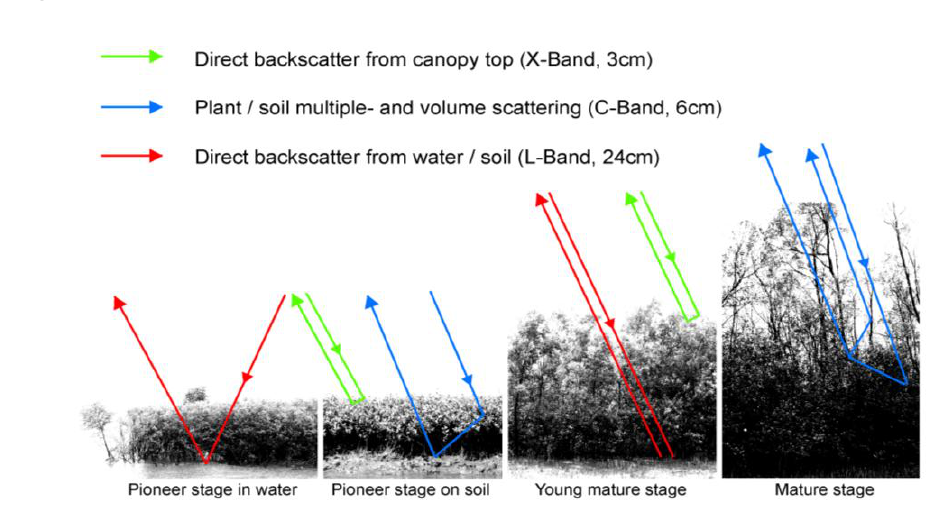
Figure 4. Dominating backscatter mechanisms at different stages of mangrove growth depending on bandwidth of the radar